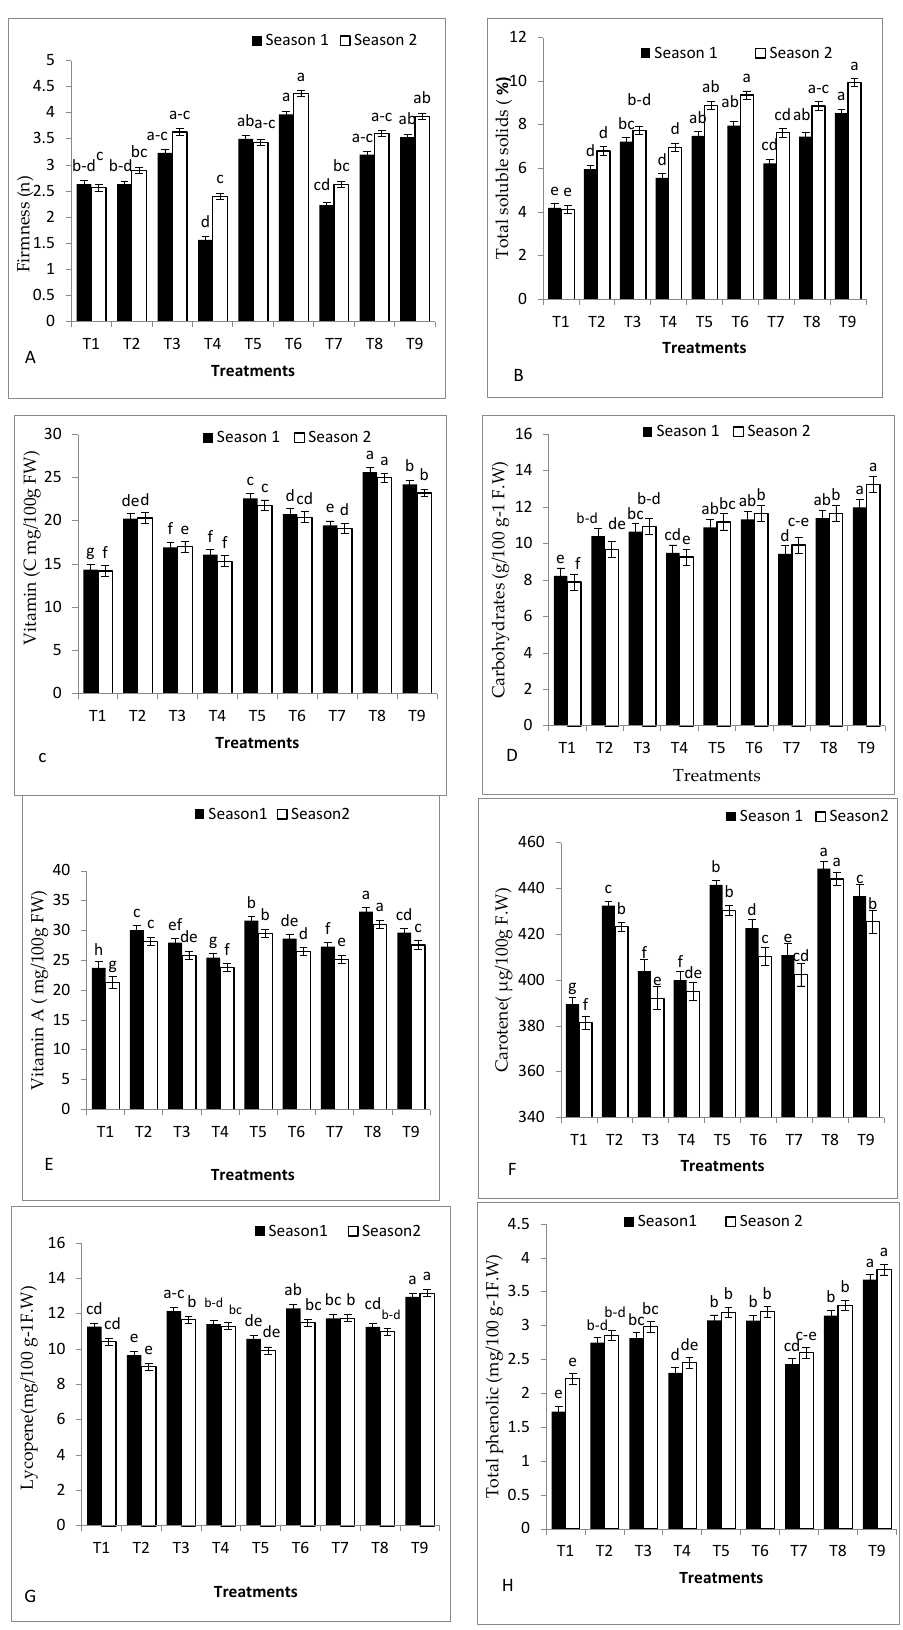
Figure 3. Effects of grafting, rootstock seed treated with SA, and colonisation with S. griseus on ( A ) firmness, ( B ) total soluble solids, ( C ) vitamin C, ( D ) total carbohydrates, ( E ) vitamin A, ( F )